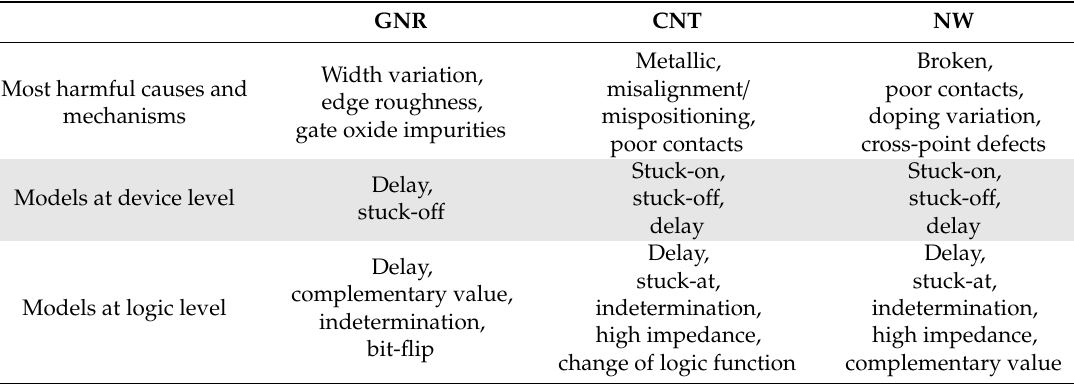
Table 2. Fault causes, mechanisms, and models of GNR, CNT and NW logic circuits. GNR CNT NW Width Most harmful causes and